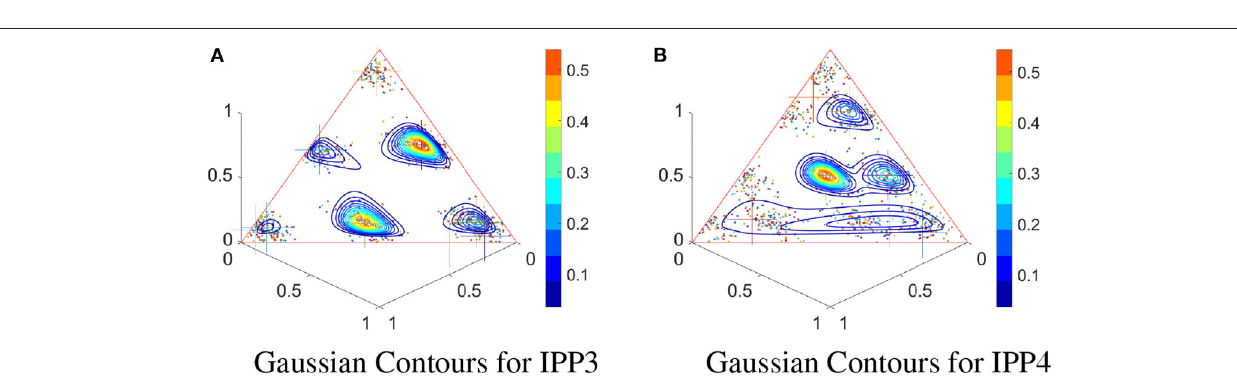
Frontiers in Applied Mathematics and Statistics |